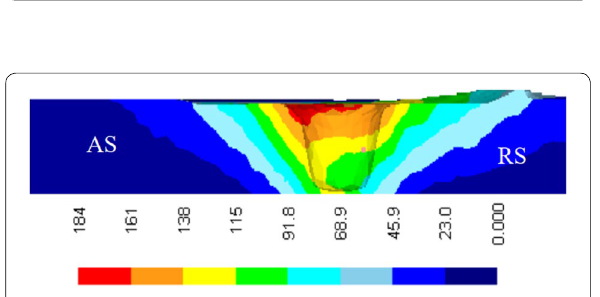
Figure 21 Stress distributions at the tool and the workpiece interface [111]